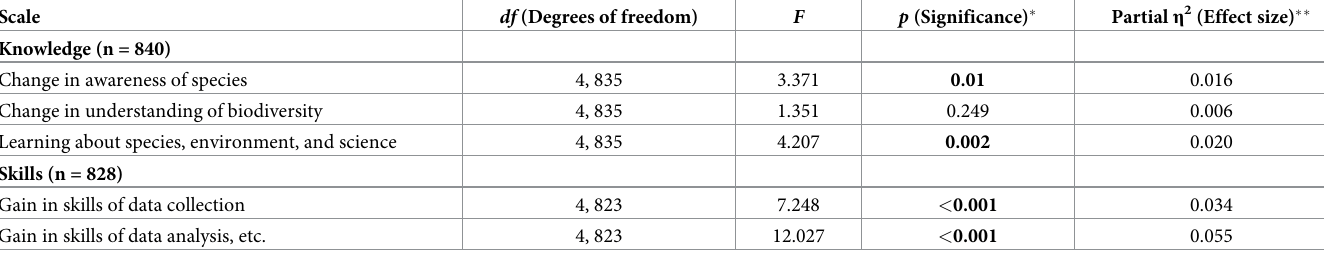
Table 8. Results of the one-way independent ANOVA test for the amount of contact between project participants and project staff. Scale df (Degrees of freedom) F p (Significance) � Partial η 2 (Effect size) �� Knowledge (n = 840) Change in awareness of species 4, 835 Change in understanding of biodiversity Learning about species, environment, and